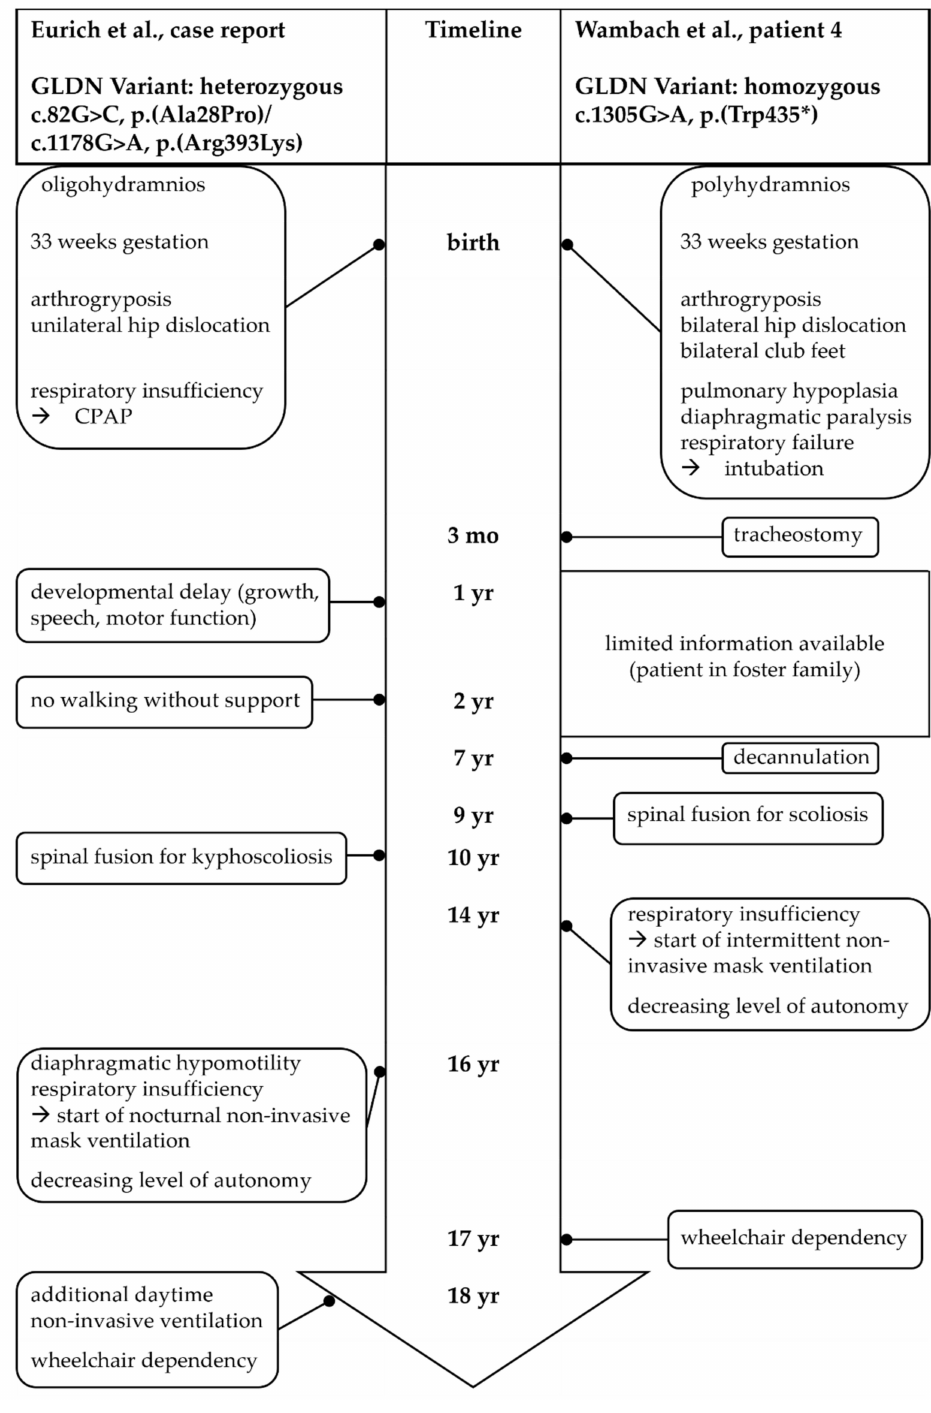
Figure 2. Comparison between LCCS11 patients with progressive clinical symptoms during adoles- cence; our patient and a patient reported by Wambach et al.